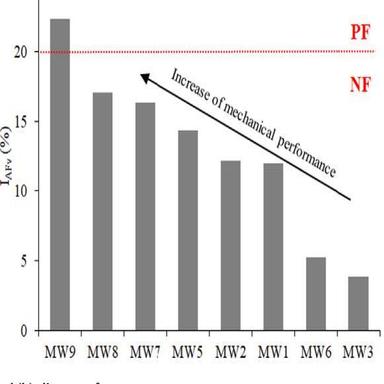
Horizontal (a) and vertical (b) alignment factors.